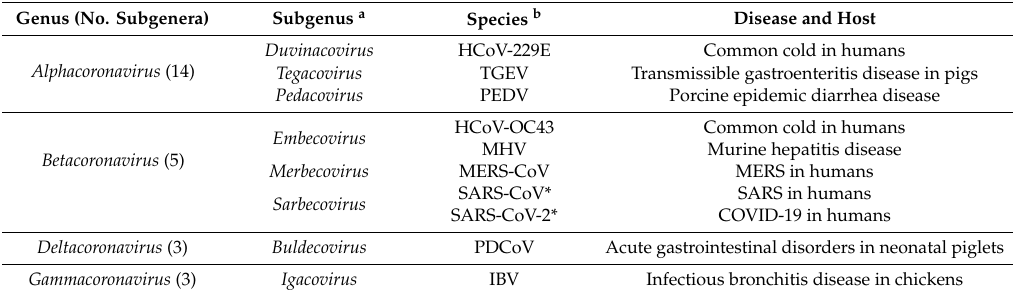
Table 1. Classification of the subfamily Orthocoronavirinae